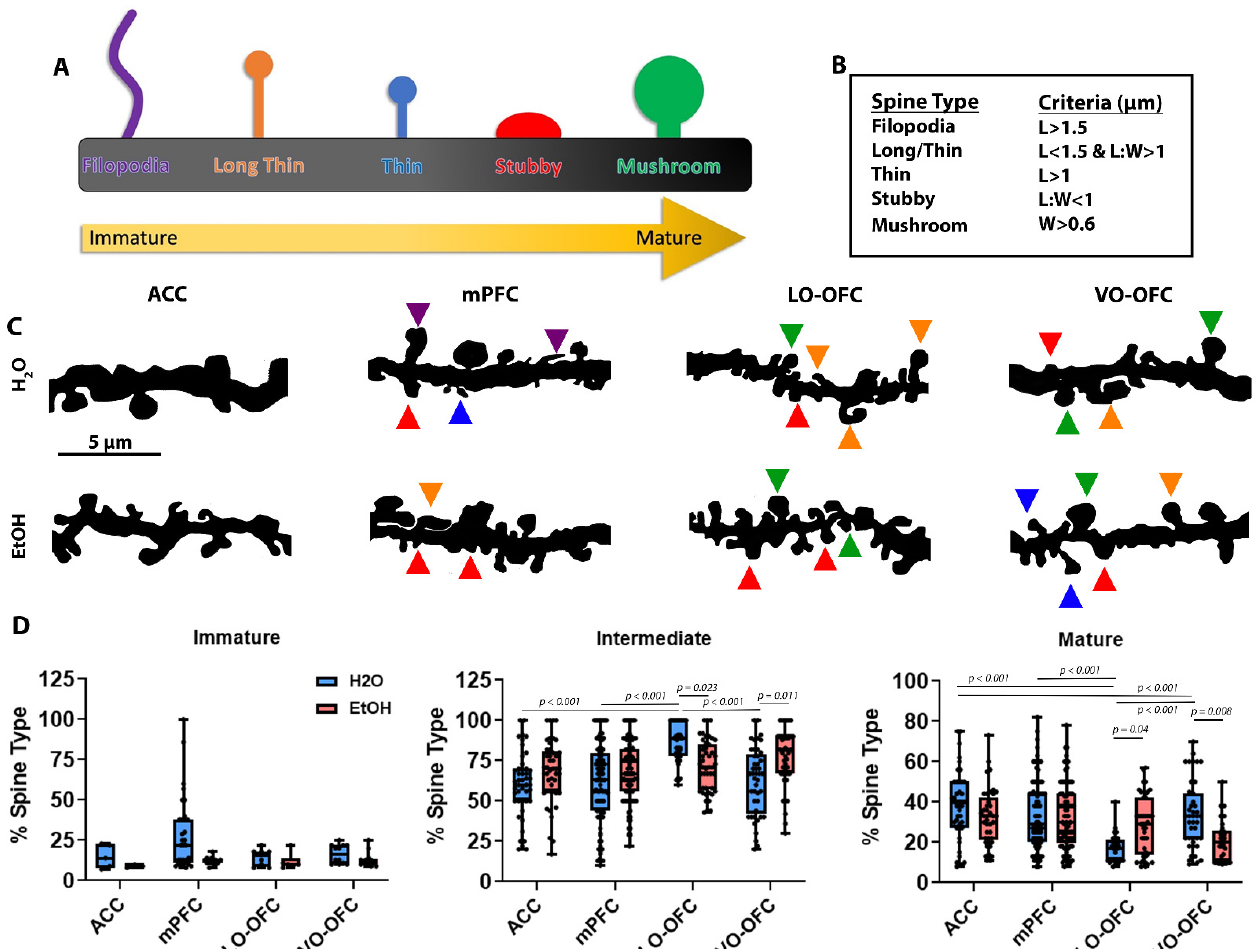
Figure 4. The effects of AIE on dendritic spine maturation after a 26-day forced abstinence period. ( A ) Cartoon representation of the classification of different dendritic spine types and how they correlate to maturation. ( B ) Table depicting how dendritic spines are classified. ( C ) Representative images of secondary dendrites depicting spine types in the ACC, mPFC (IL/PL), LO-OFC, and VO-OFC. Triangles indicate spine type based on color: Filopodia—purple; Long Thin—orange; Thin— blue; Stubby—red; Mushroom—green. ( D ) Analysis of dendritic spine maturation in the ACC, mPFC (IL and PL), LO-OFC, and VO-OFC. There was no change in the % of immature dendritic spines in any subregion ( p > 0.05) following AIE or when comparing subregions ( p > 0.05). In the LO-OFC, there was a significant decrease in intermediate spines ( p = 0.023) and an increase in mature